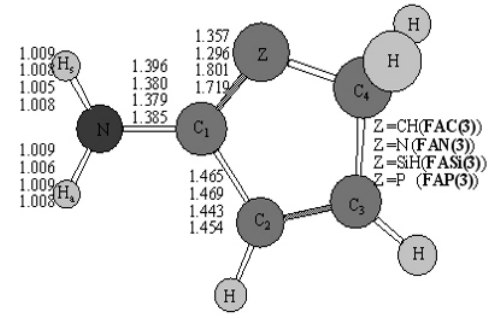
Figure 2. MP2/cc-pVTZ geometries of FAY(2) (Y=C, N, Si, and P) with the bond lengths in angstroms.